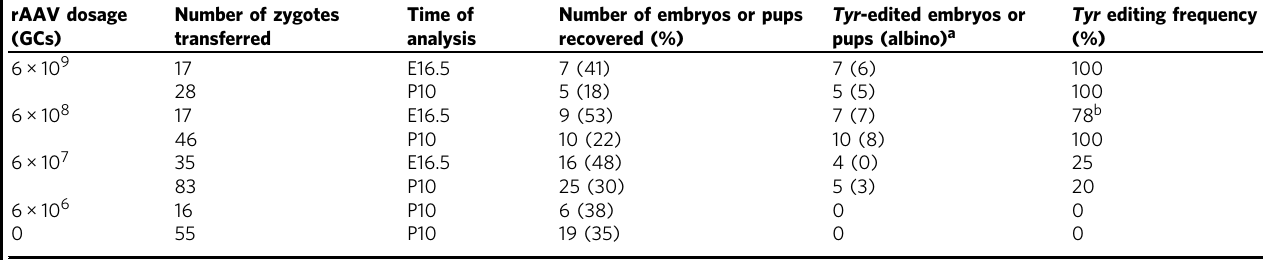
Table 4 Ex vivo gene editing after transduction of C57BL/6NJ zygotes with CRISPR-Cas9 rAAV